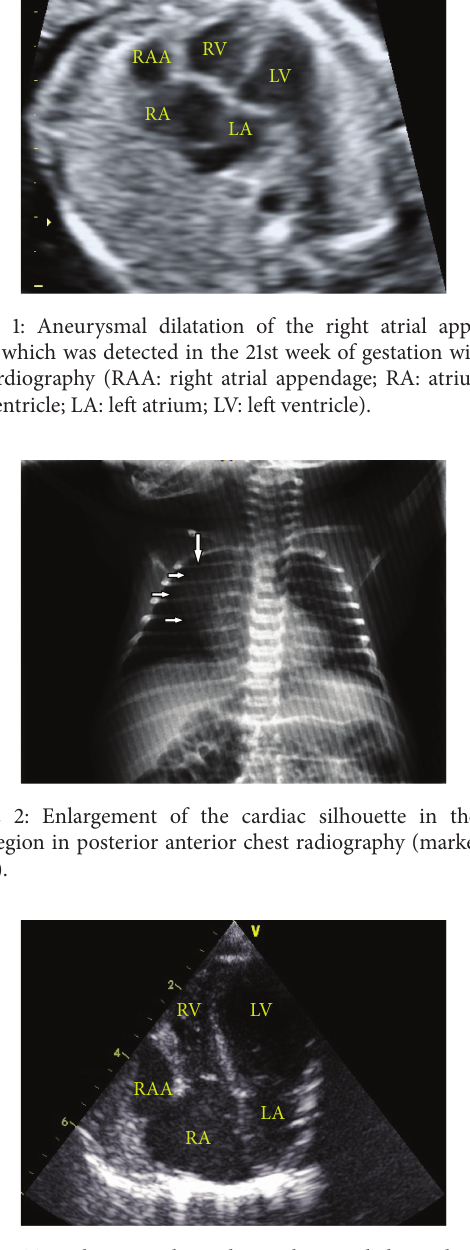
Figure 3: Transthoracic echocardiography revealed an enlargement of the aneurysm on anterior and right of the RA (RAA) (RAA: right atrialappendage;RA:atrium;RV:rightventricle;LA:leftatrium;LV: left ventricle.).